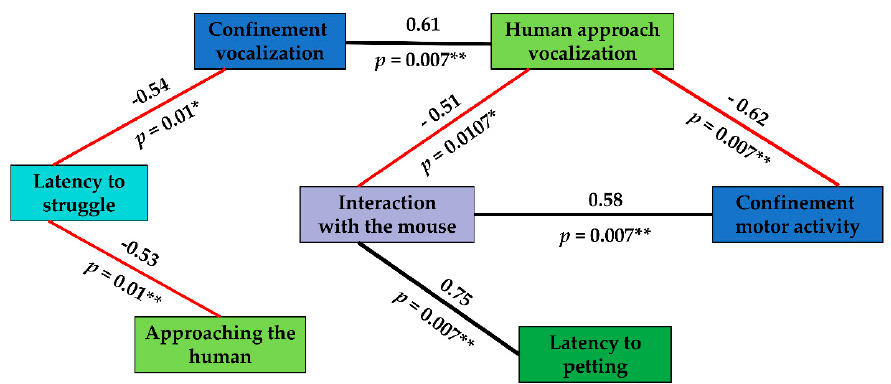
Figure 1. Correlations between behavioural variable scores showing stable individual di ff erences at the between-individual level. Asterisks indicate significance levels at p < 0.05 *, p < 0.01 **. Black lines correspond to positive correlations, red lines correspond to negative correlations. Line thickness corresponds to the strength of a correlation. Further details are available in Supplementary Material Table S5, including confidence intervals.